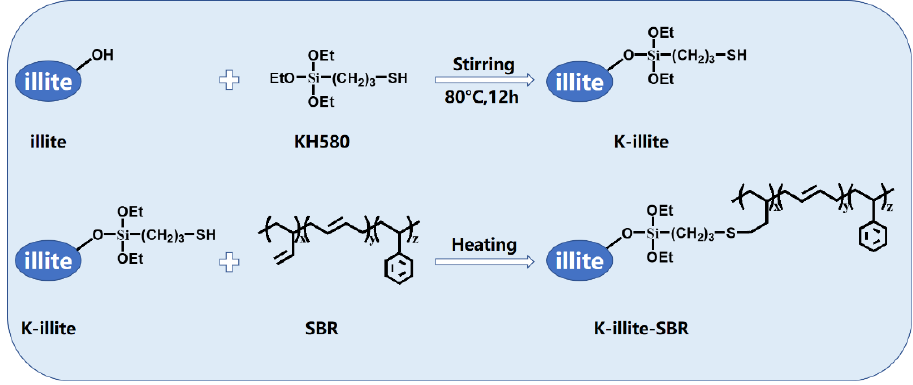
Figure 3. The proposed interaction between illite and SBR molecule in the incorporation of KH580.